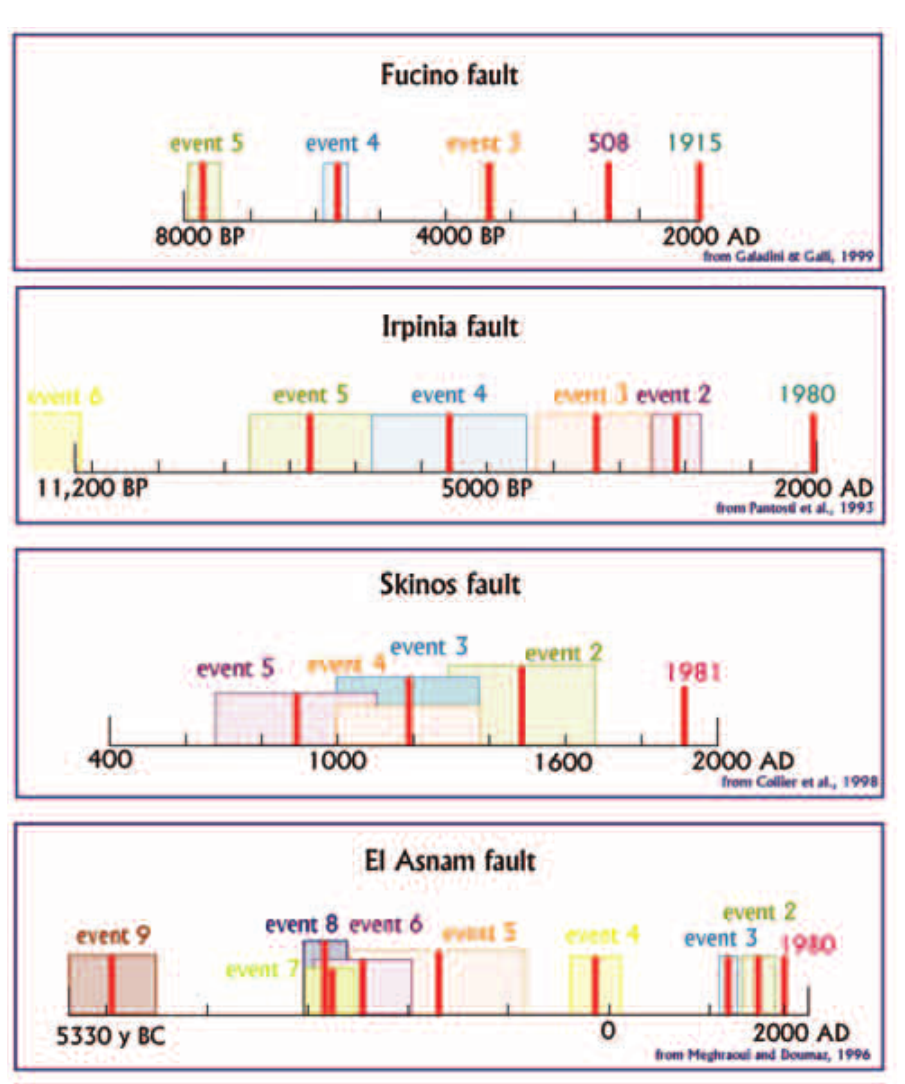
Fig. 4. Ages of paleoearthquakes and associated uncertainty for the four faults used in the test (data from Pantosti et al. , 1993; Meghraoui and Doumaz, 1996; Collier et al ., 1998; Galadini and Galli, 1999). Note that large uncertainties are generally associated with paleoseismological